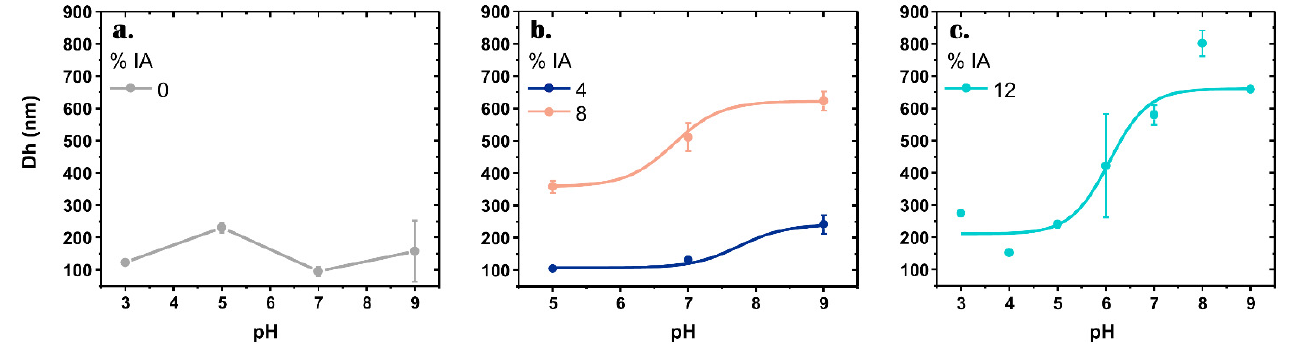
Figure 4. The effect of pH on the hydrodynamic particle diameter of: ( a ) HNG-P(DEGMA); ( b ) HNG-P(DEGMA-co-IA 4 ) and HNG-P(DEGMA-co-IA 8 ) and ( c ) HNG-P(DEGMA-co-IA 12 ).